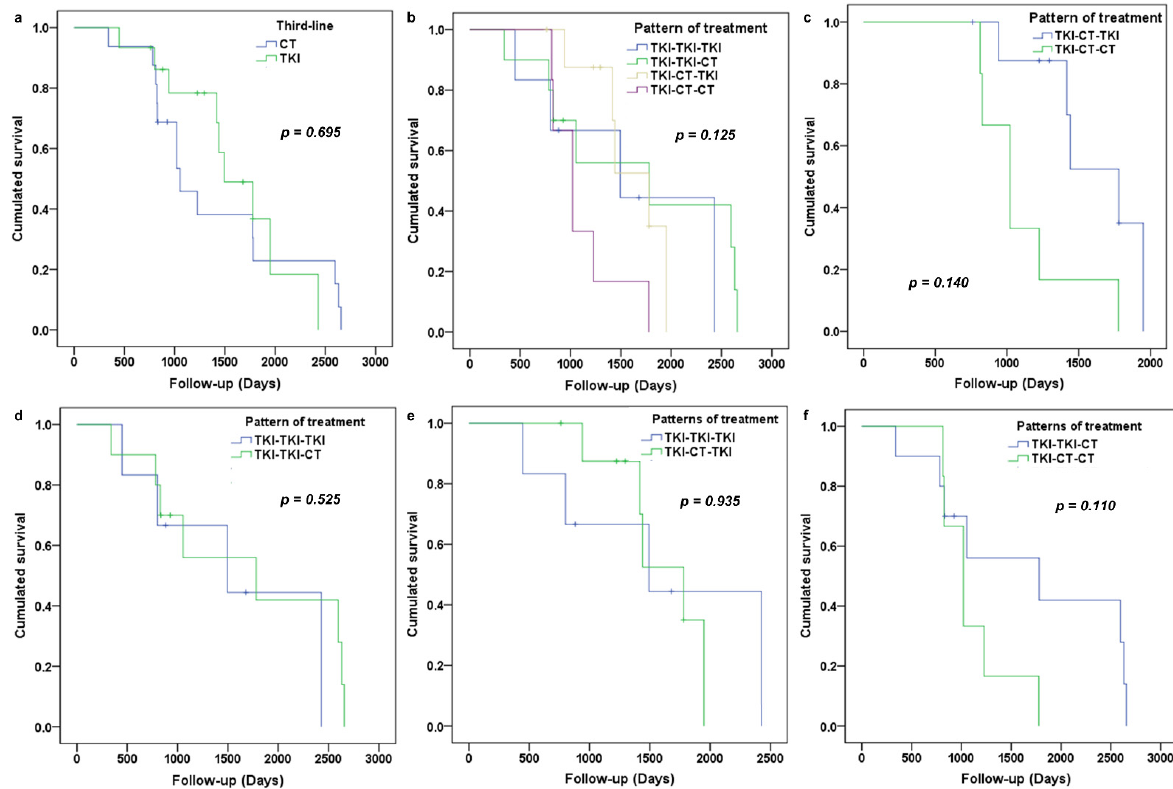
Figure 3. OS according to the treatment received in third-line ( a ), according to the pattern of treatment ( b ), according to the choice of third-line for patient which received CT in second-line ( c ) and according to the choice of third-line for patient who received TKI in second-line ( d ). ( e , f ) represent respective OS according to choice of second-line for patient which received TKI in third-line and CT in third-line.